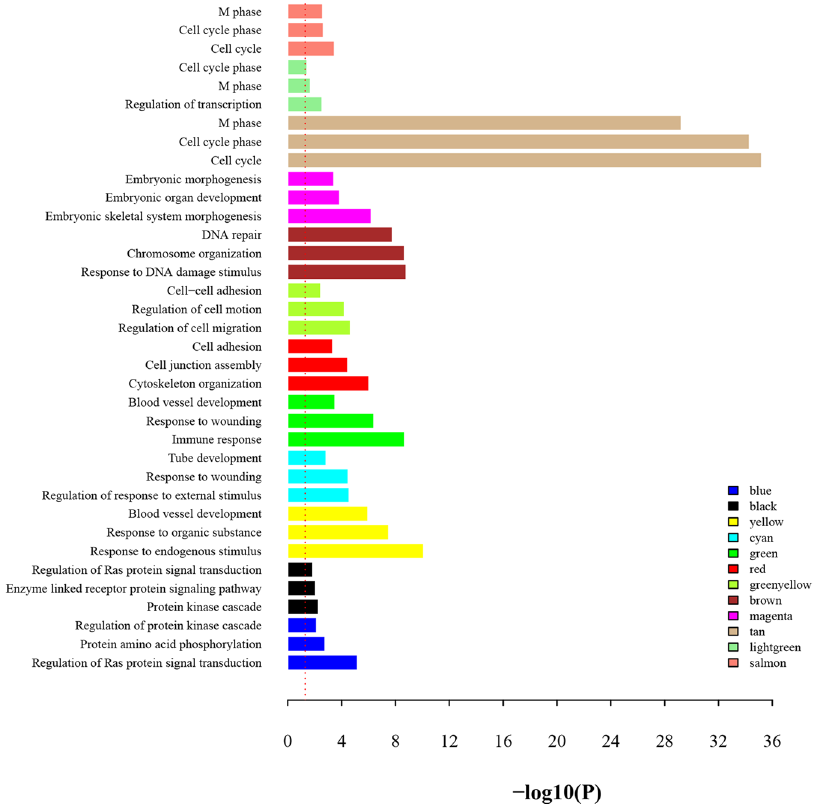
Figure 4. Barplot of representative GO biological process (BP) terms of 12 modules. Three representative GO BP terms were chosen from top 10 significant terms for each module. The y-axis depicts names of BP terms, and the x-axis depicts − log10 (P-value). Bar color denotes the module color. The red dotted line denotes p-value of